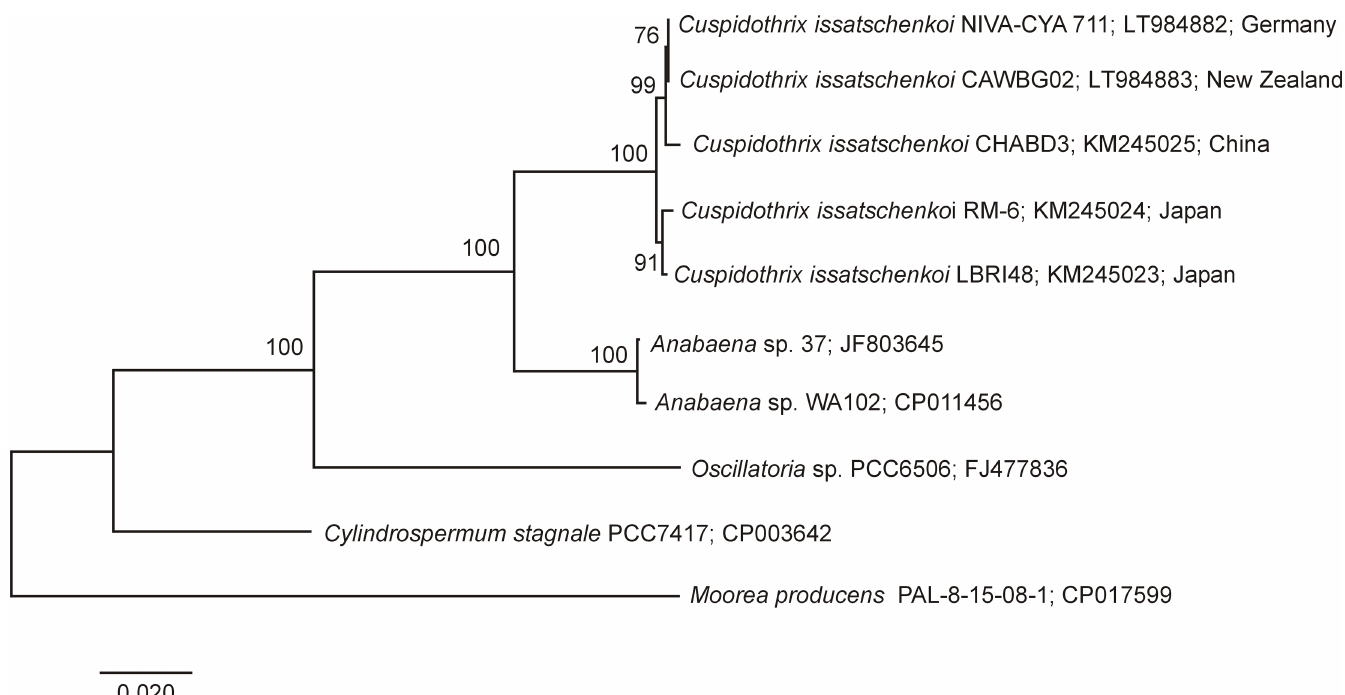
Fig 3. Maximum Likelihood tree based on the anaF gene clusters of the five Cuspidothrix issatschenkoi strains included in this study. anaF genes of Anabaena sp., Oscillatoria sp., Cylindrospermum stagnale are included in the tree. A homologous sequence of Moorea producens is used as outgroup. Bootstrap values above 50 are included. The scale bar indicates 2% sequence divergence.